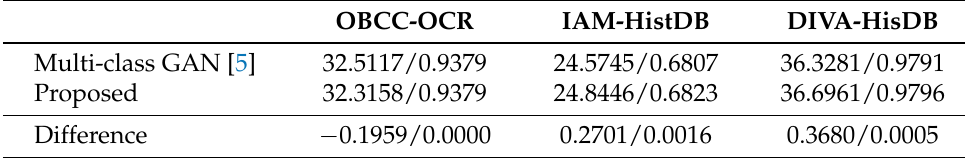
Table 4. Performance comparison between the proposed and multi-class GAN-based methods. The values to the left and right of ‘/’ represent the PSNR and SSIM,